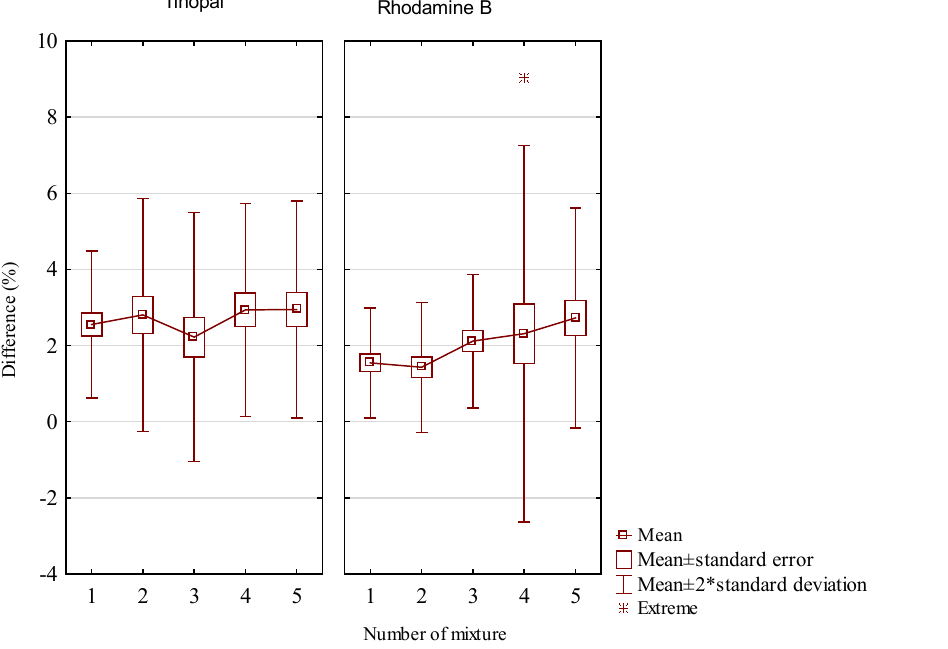
Figure 2 : Graph box plot of the difference in percentage share of tracer covered with Tinopal and Rhodamine B for the tested feed mixtures. Table 4: Coefficients of variation (CV) of homogeneity of mixtures. Number of